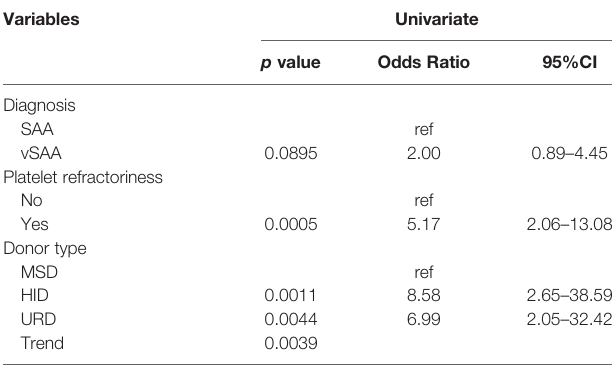
TABLE 3 | Univariate logistic regression analysis of risk factors for